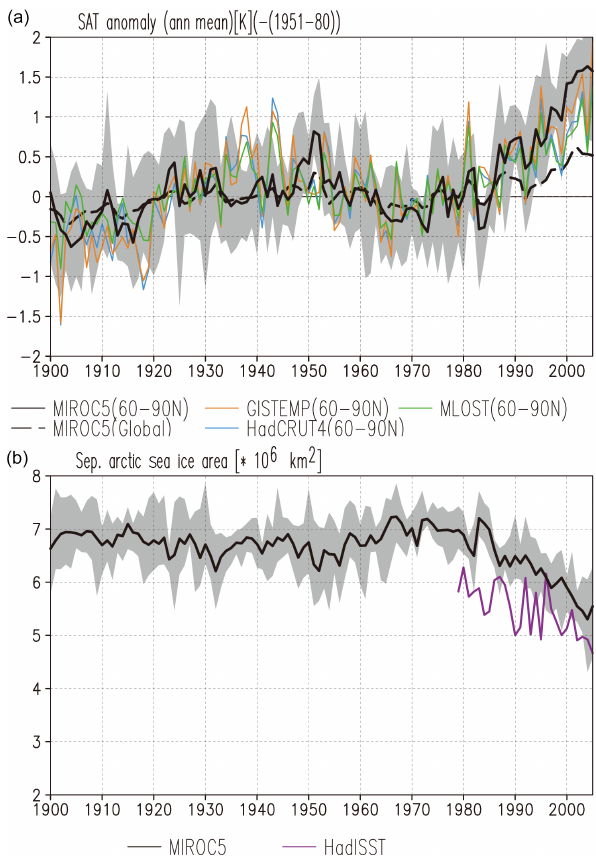
Figure 1. (a) Time series of the surface air temperature (SAT) anomaly from the 1951–1980 mean. Solid black, green, orange, and blue lines are the SAT anomalies averaged over 60–90 ◦ N in MIROC5’s ensemble mean, MLOST, GISTEMP, and HadCRUT4, respectively. The broken black line is the global and ensemble mean SAT anomaly in MIROC5. The gray shaded area indicates the maxi- mum and minimum SAT anomalies between the ensemble members of MIROC5. (b) Time series of the September sea ice extent. The black lines represent the ensemble mean. The gray shaded area in- dicates the maximum and minimum ensemble members. The purple line is the September sea ice extent calculated from HadISST. The units of the SAT anomaly and sea ice extent anomaly are K and 10 6 km 2 ,